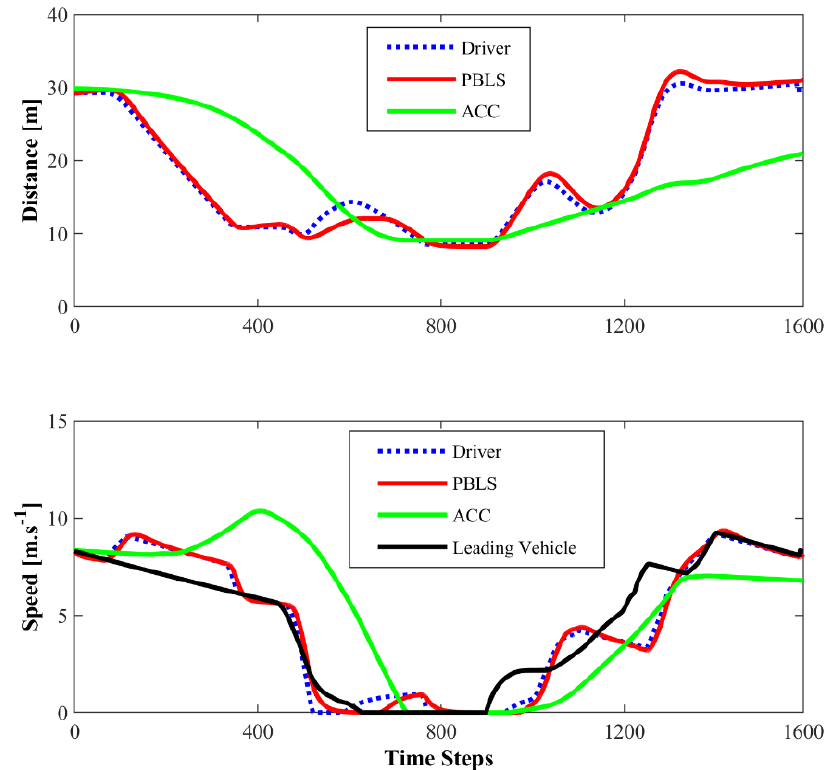
Sensors 2019 , 19 , x FOR PEER REVIEW Figure 9. Distance and speed for Driving Scene II. Figure 9. Distance and speed for Driving Scene II.